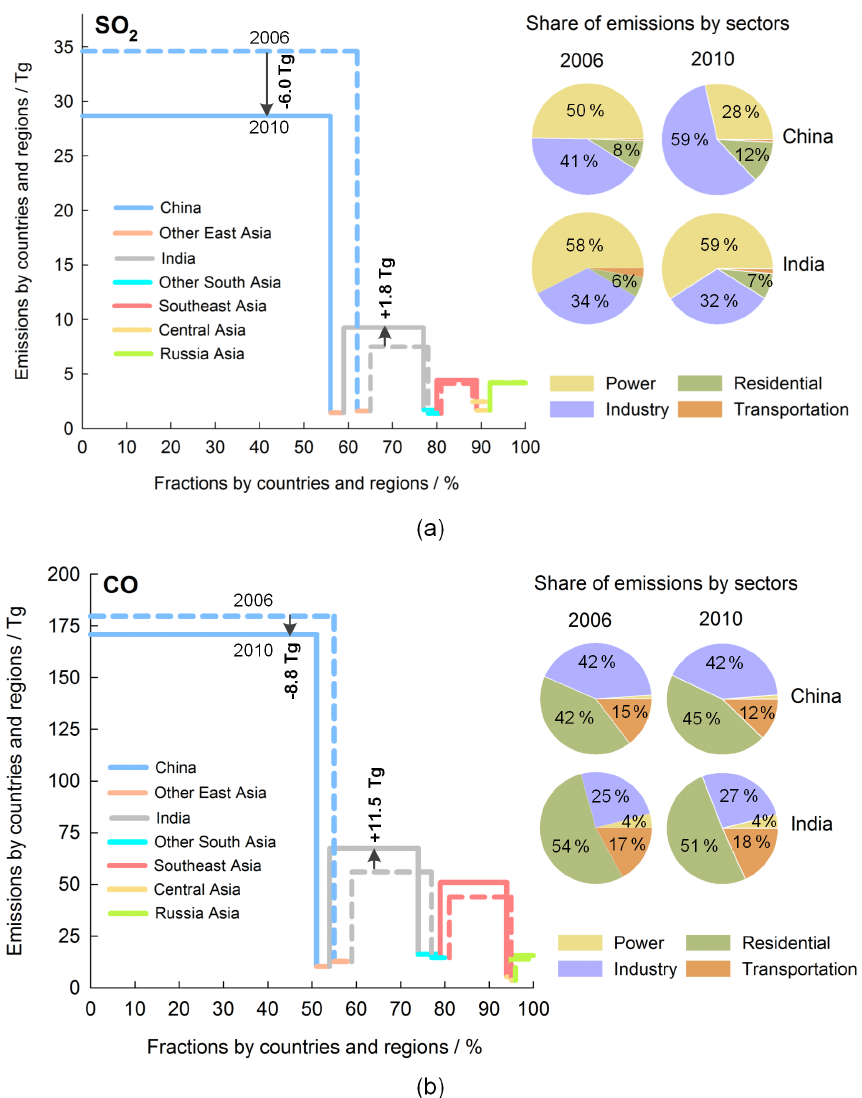
Figure 8. Emission changes from 2006 to 2010 by Asian regions for SO 2 (a) and CO (b) . Left panel: emissions in 2006 and 2010 by region. Y axis represents emissions by region. X axis represents accumulative emission contribution of regions. The dotted and solid lines represent emissions in 2006 and 2010 respectively. Right panel: the shares of emissions by sectors over China and India in 2006 and 2010.